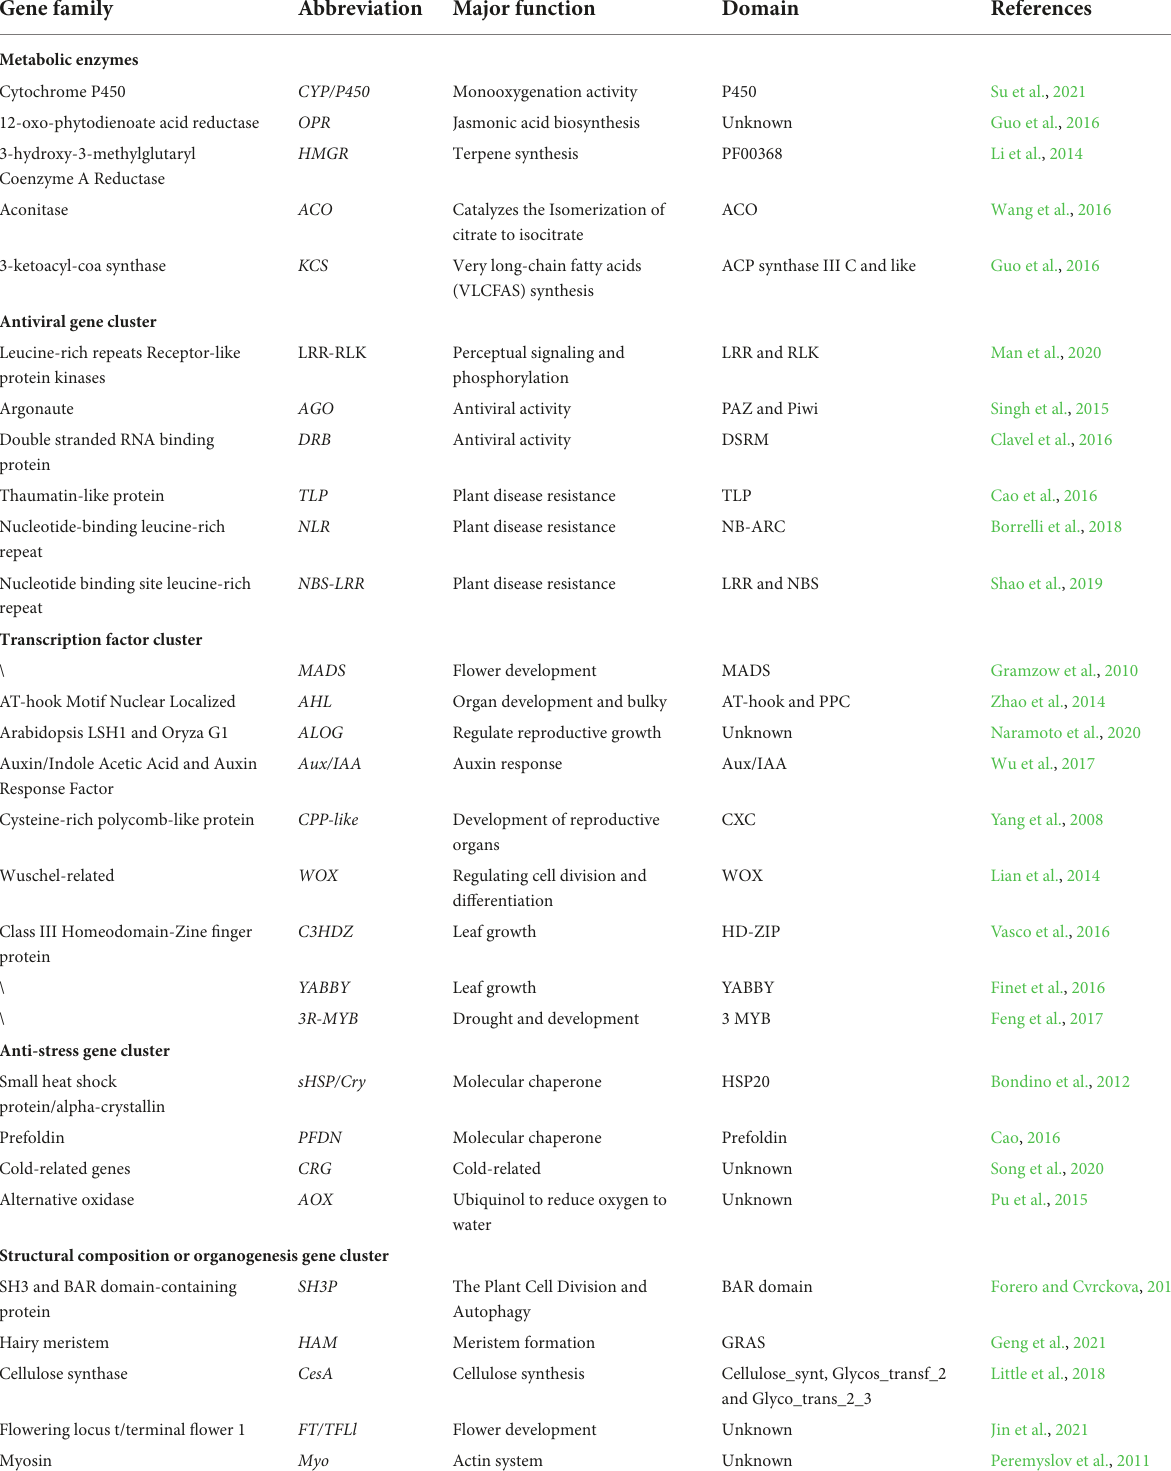
TABLE 1 Structural analysis of plant protein-coding gene